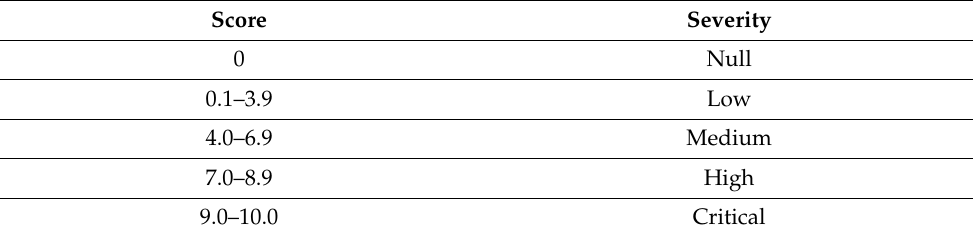
Table 9. Common Vulnerability Scoring System Version 3 (CVSSv3)